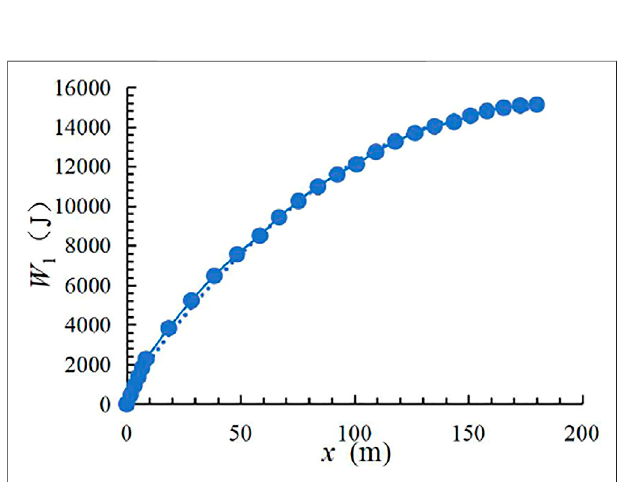
FIGURE 4 | The kinetic energy of reel rotation. FIGURE 5 | Accumulated energy consumption of reel